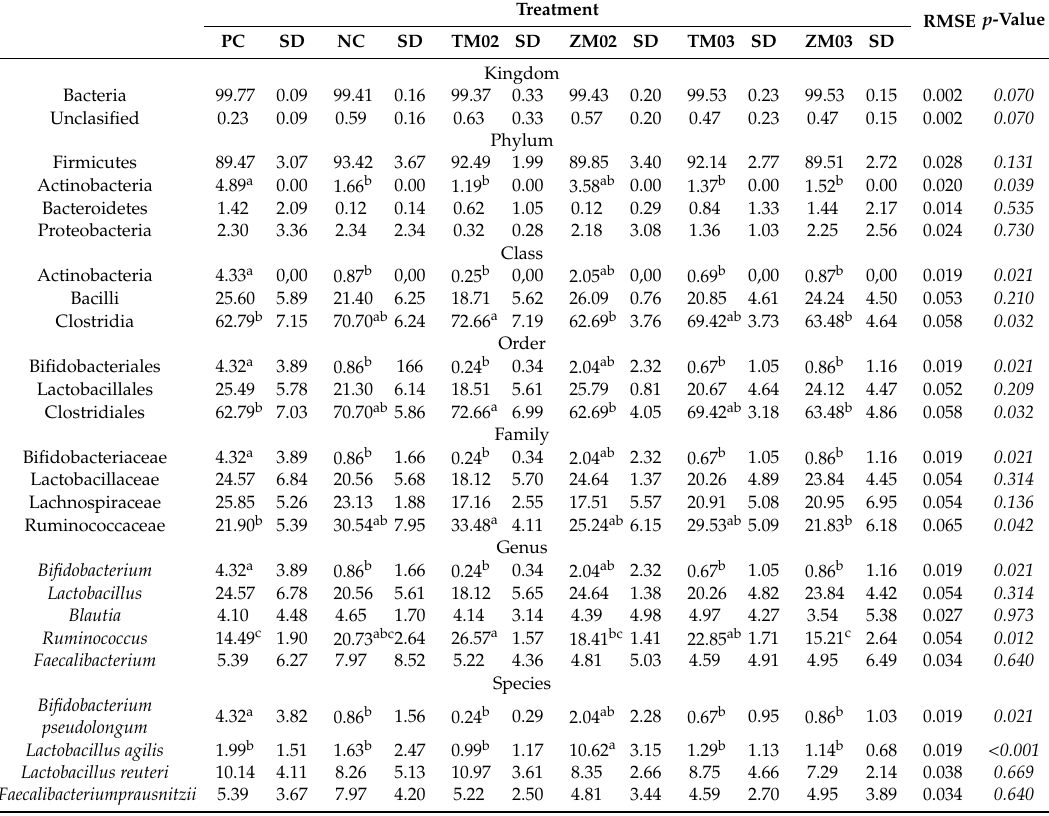
Table 3. Relative abundance of bacterial communities in cecal digesta of chickens fed: 0.2%